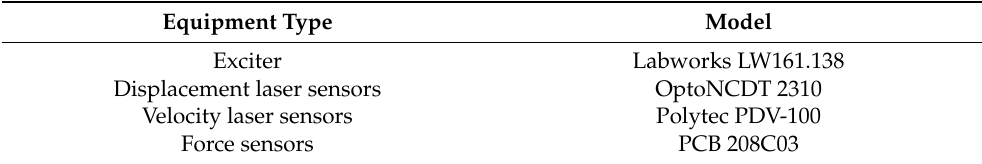
Table 3. The equipment details for the experiment.